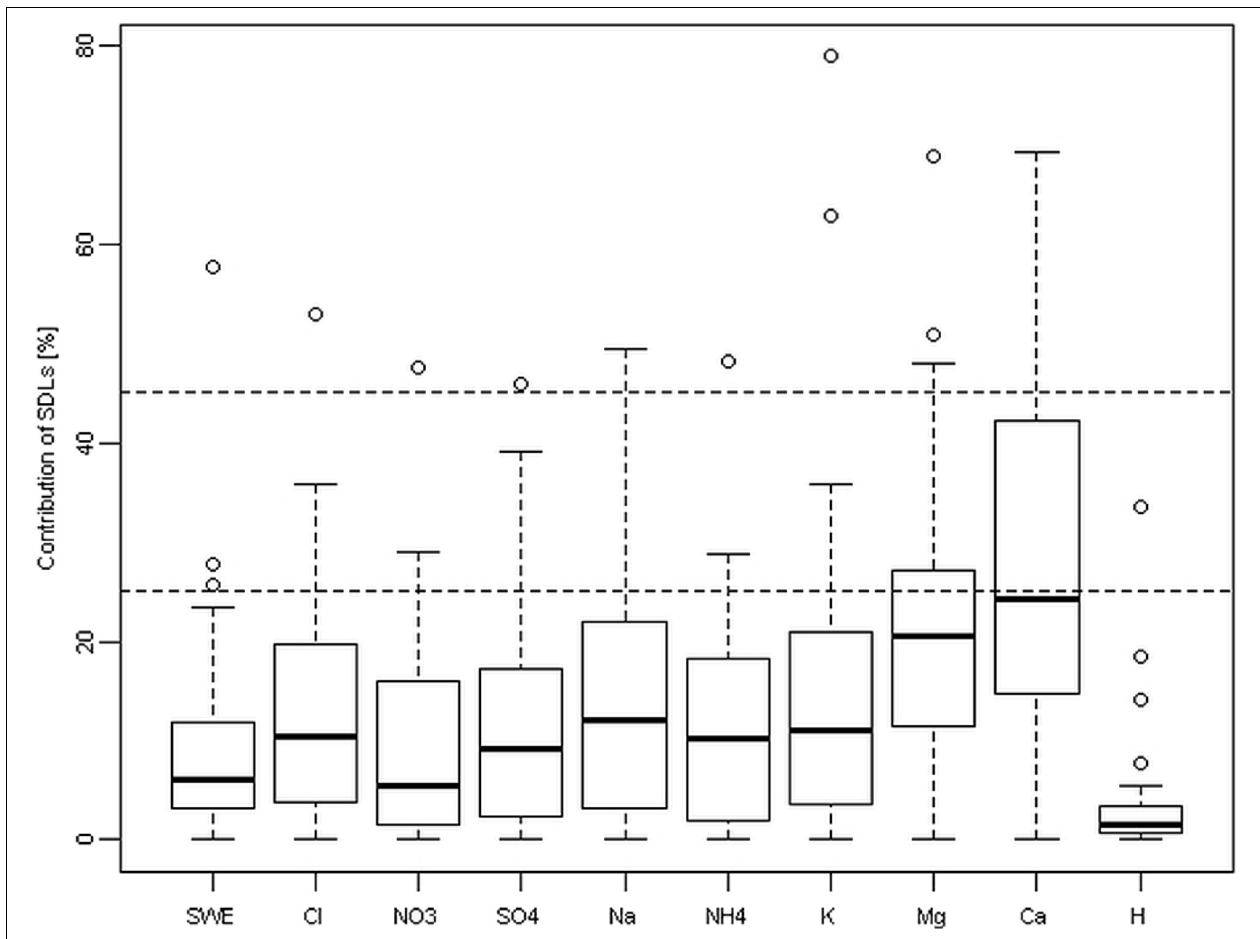
FIGURE 6 | Boxplot of the annual contributions of Saharan dust layers (SDLs) to the snow water equivalent (SWE) and the annual depositions of the single ions. The box represents the 25th and 75th percentile, the bold black line shows the median and whiskers extend to the most extreme data point which is no more than 1.5 times the interquartile range of the box. Dashed lines mark 25% and 45% contributions of